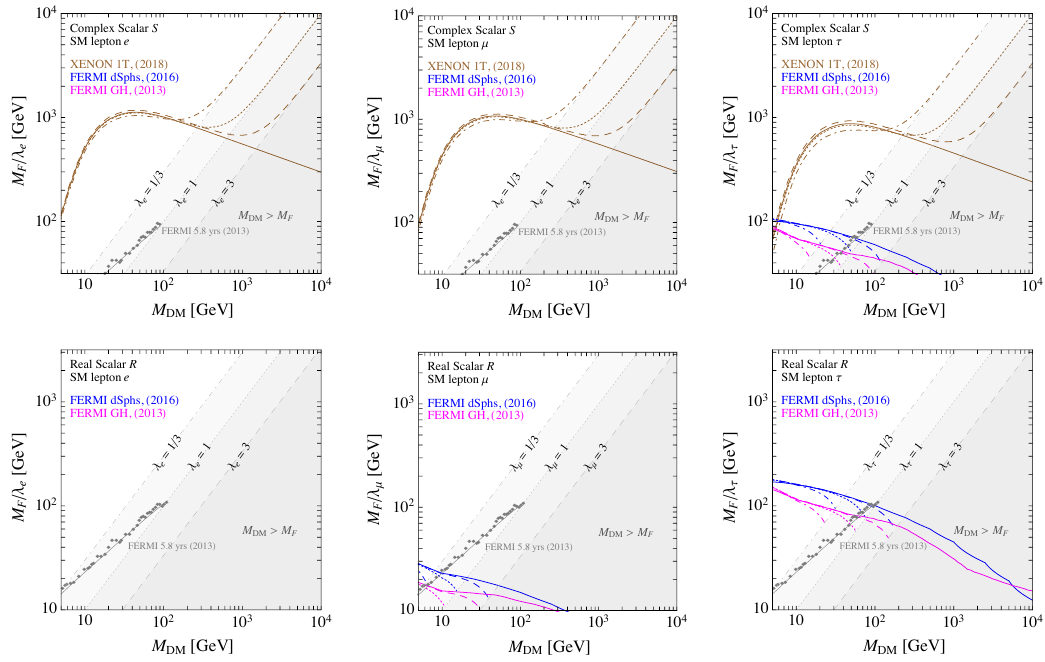
Figure 8 . Same as (cid:12)gure 7, but for complex scalar (upper panel) and real scalar DM (lower panel). We also show the limit from gamma ray line searches with FERMI (grey diamonds) and H.E.S.S. (red circles). Note that the bounds from line searches do not strictly apply whenever the continuum limits